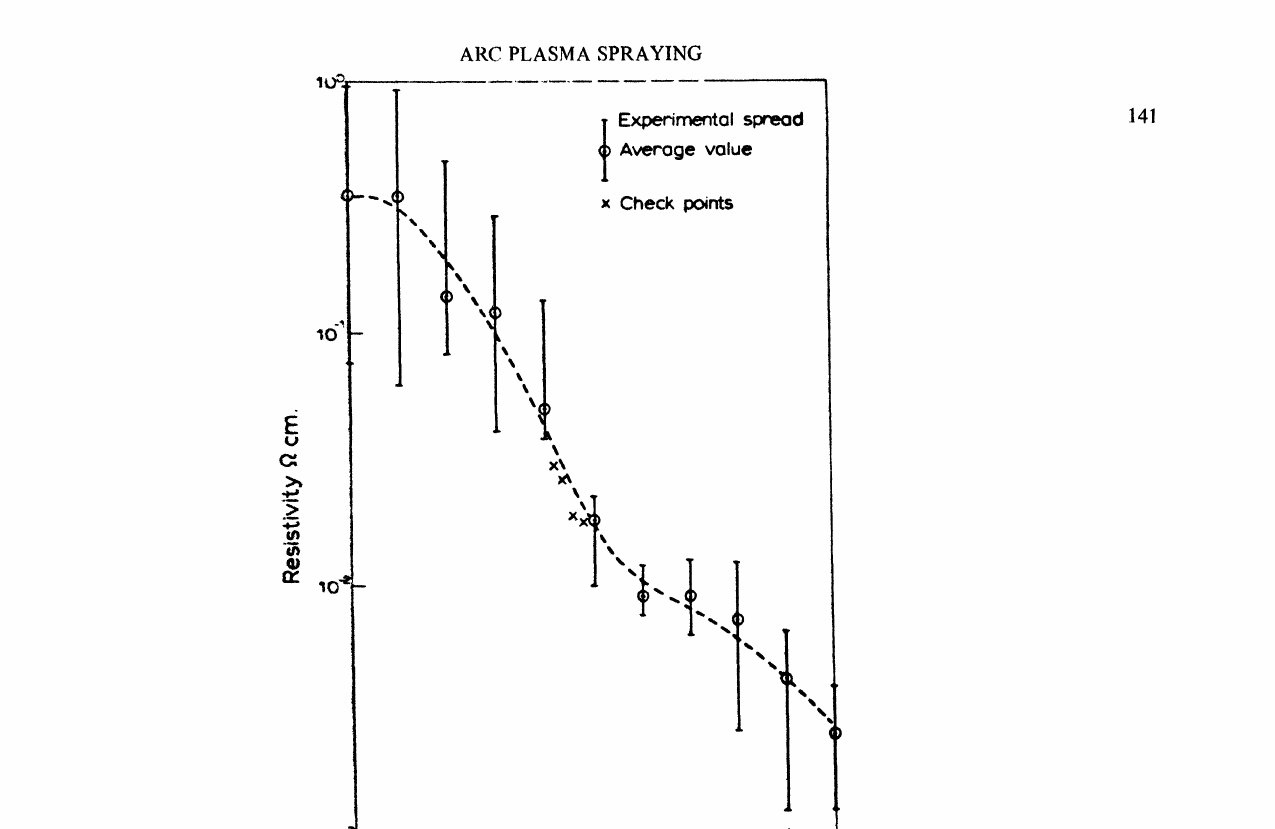
FIGURE 8 substrate.